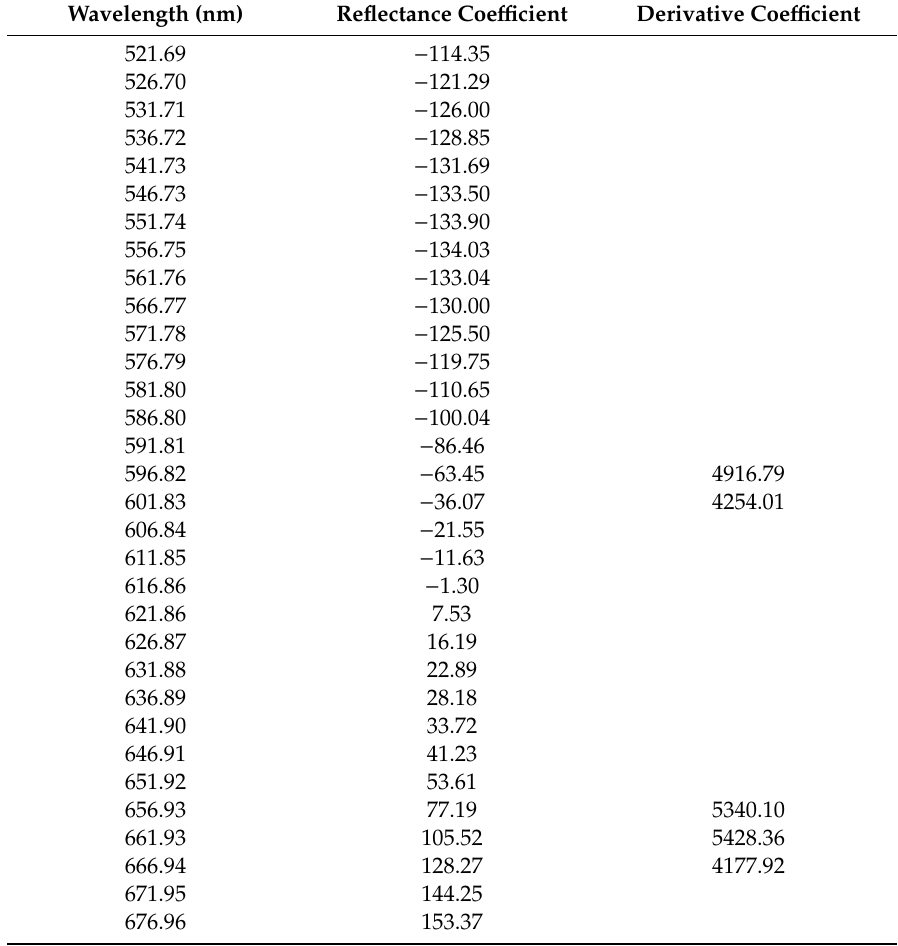
Table A1. AVIRIS-NG PLSR